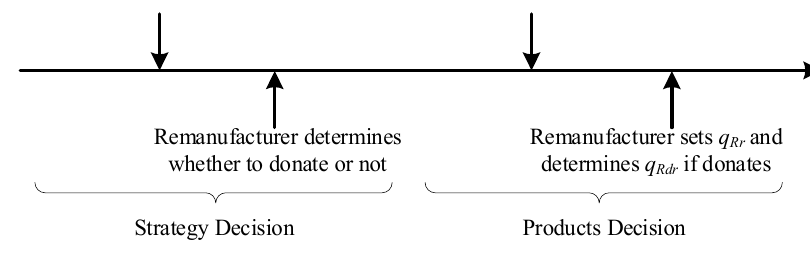
Figure 2. The game sequences. Table 3. Donation strategies.